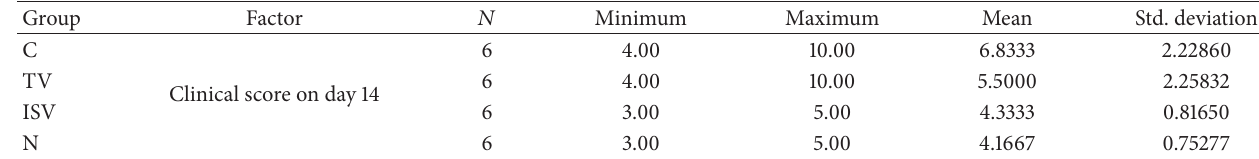
Table 3: Mean clinical scores obtained from each group on day 14.